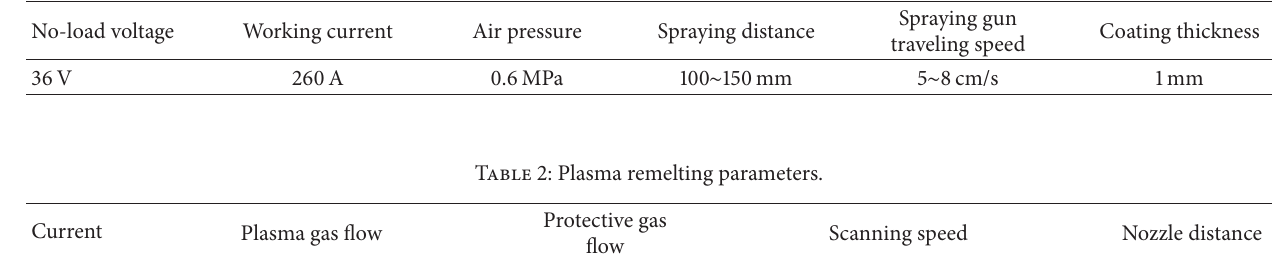
Table 1: Arc spraying parameters.